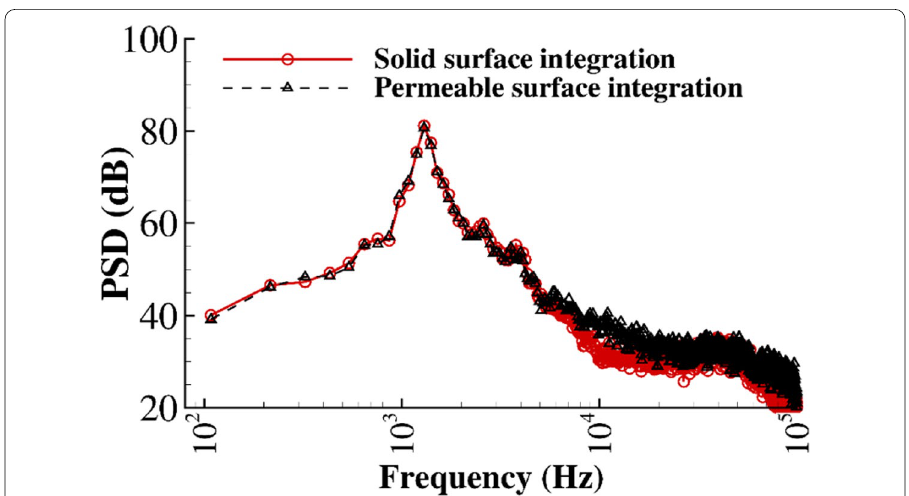
Fig. 17 Comparison between solid-surface integration and permeable surface integration ( r